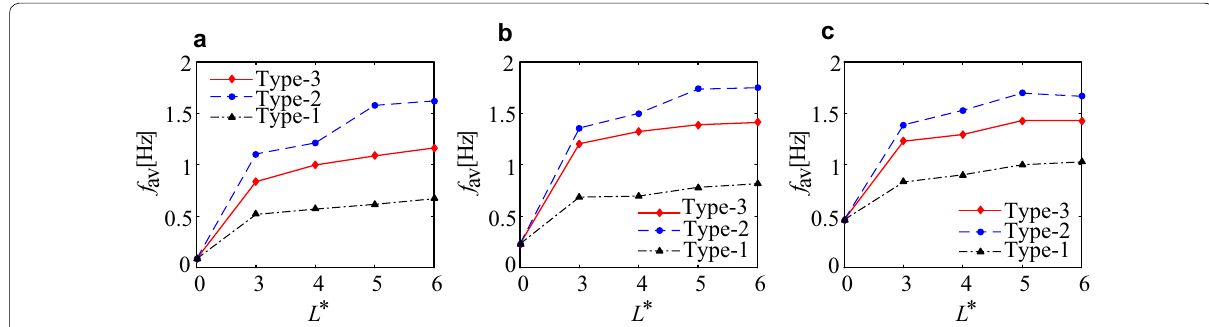
Fig. 6 Averaged L/D cycle frequency of three types of PBRs with different L *. L * serves as a benchmark here; the incident light intensity is a 375 μmol m − 2 s − 1 , b 800 μmol m − 2 s − 1 and c 1200 μmol m − 2 s −